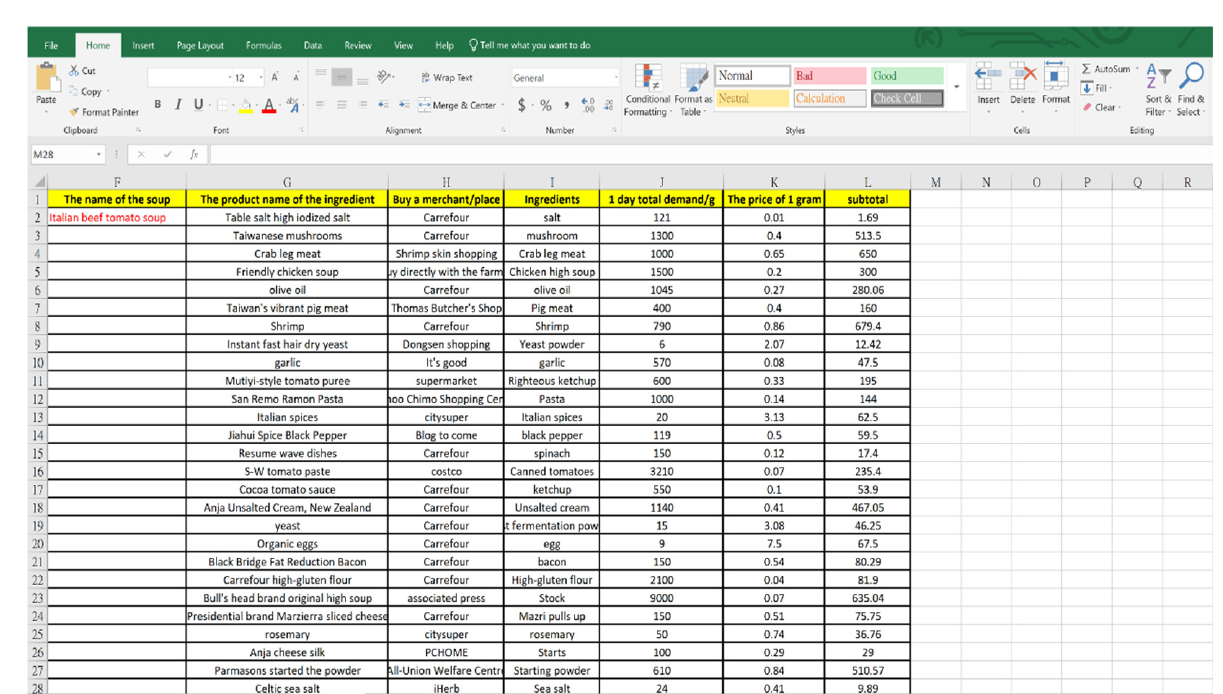
Table 1. Summary of the experimental design.